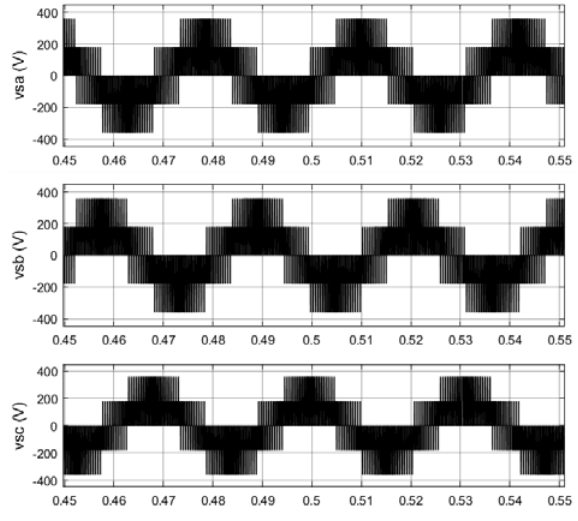
Fig. 5. Stator voltages of induction motor